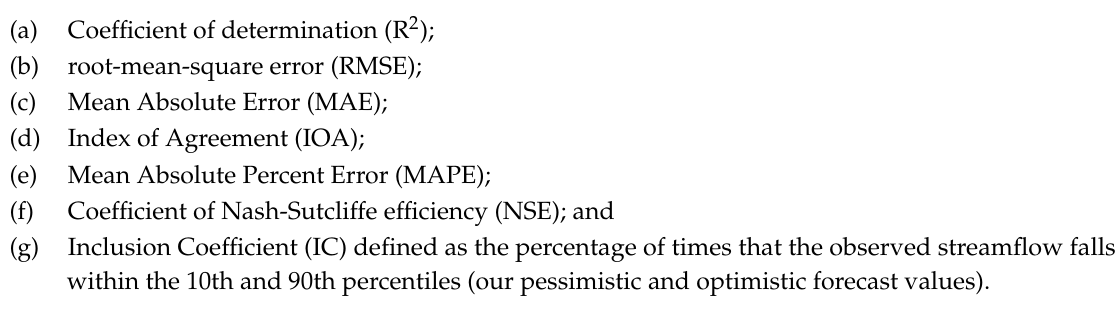
Figure 8. Example of typical model forecast outputs results compared with the historical observed streamflow data.